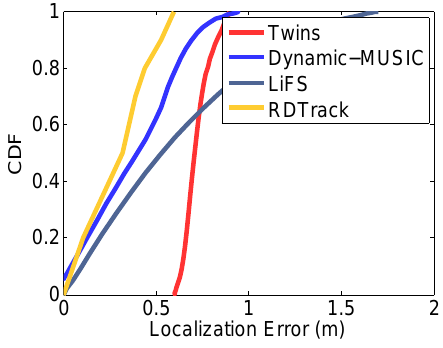
Figure 13. CDF plot of the localization